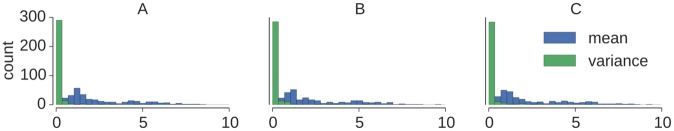
Mean and variance of inferred parameters.The across-subset mean and variance of inferred parameter values for each human in the Adaptive data set across 10 disjoint subsets of the data.